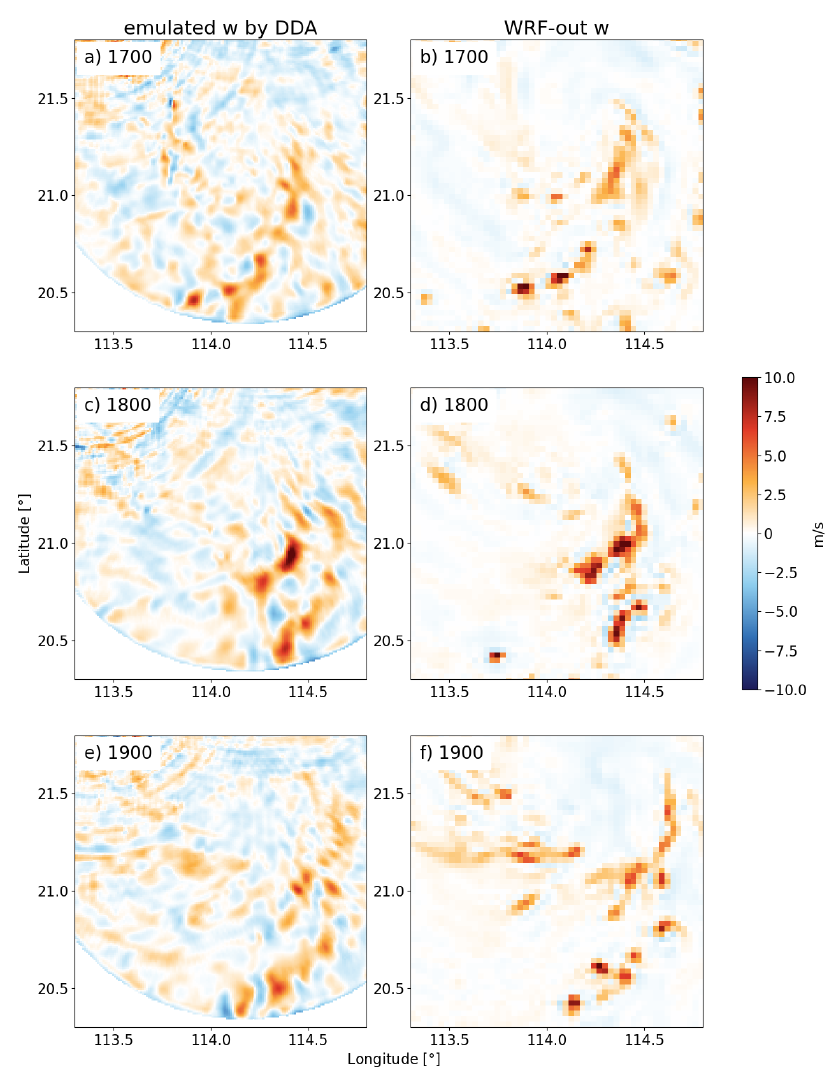
Figure 6. Comparison of the vertical velocity at 5 km altitude ( a , c , e ) of Typhoon Higos retrieved by the DDA method based on the CR-SIM-emulated radial velocities from Zhuhai–Macao radar and HK Tate’s Cairn radar with the vertical velocity w at 5 km altitude ( b , d , f ) from WRF-out at ( a , b ) 17:00, ( c , d ) 18:00 and ( e , f ) 19:00 UTC. The warm color is rising speed. The cold color is sinking speed.